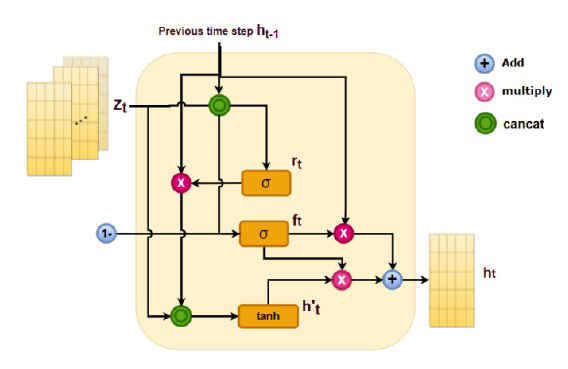
Figure 4. Based on the information extraction structure of GRU, the feature relationship Zt obtained through the attention mechanism is used as input and decodes through various gated structures to get a new data